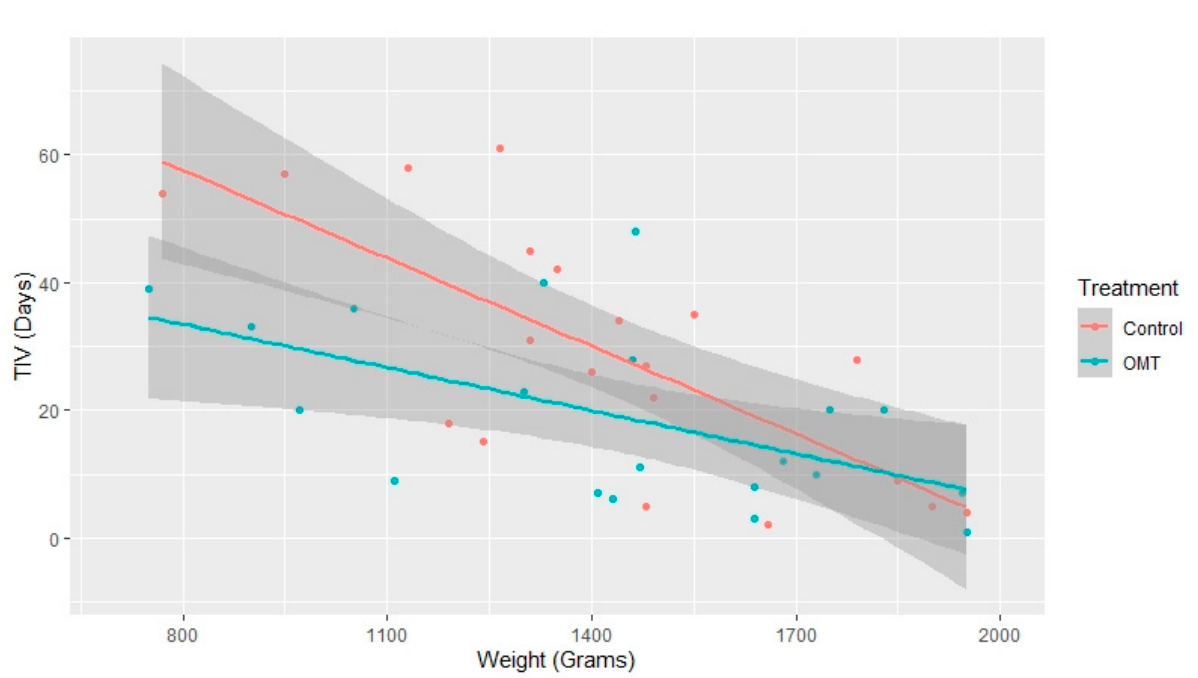
Figure 3. Distribution of ventilation weaning in the function of the birth weight stratified by OMT exposure.